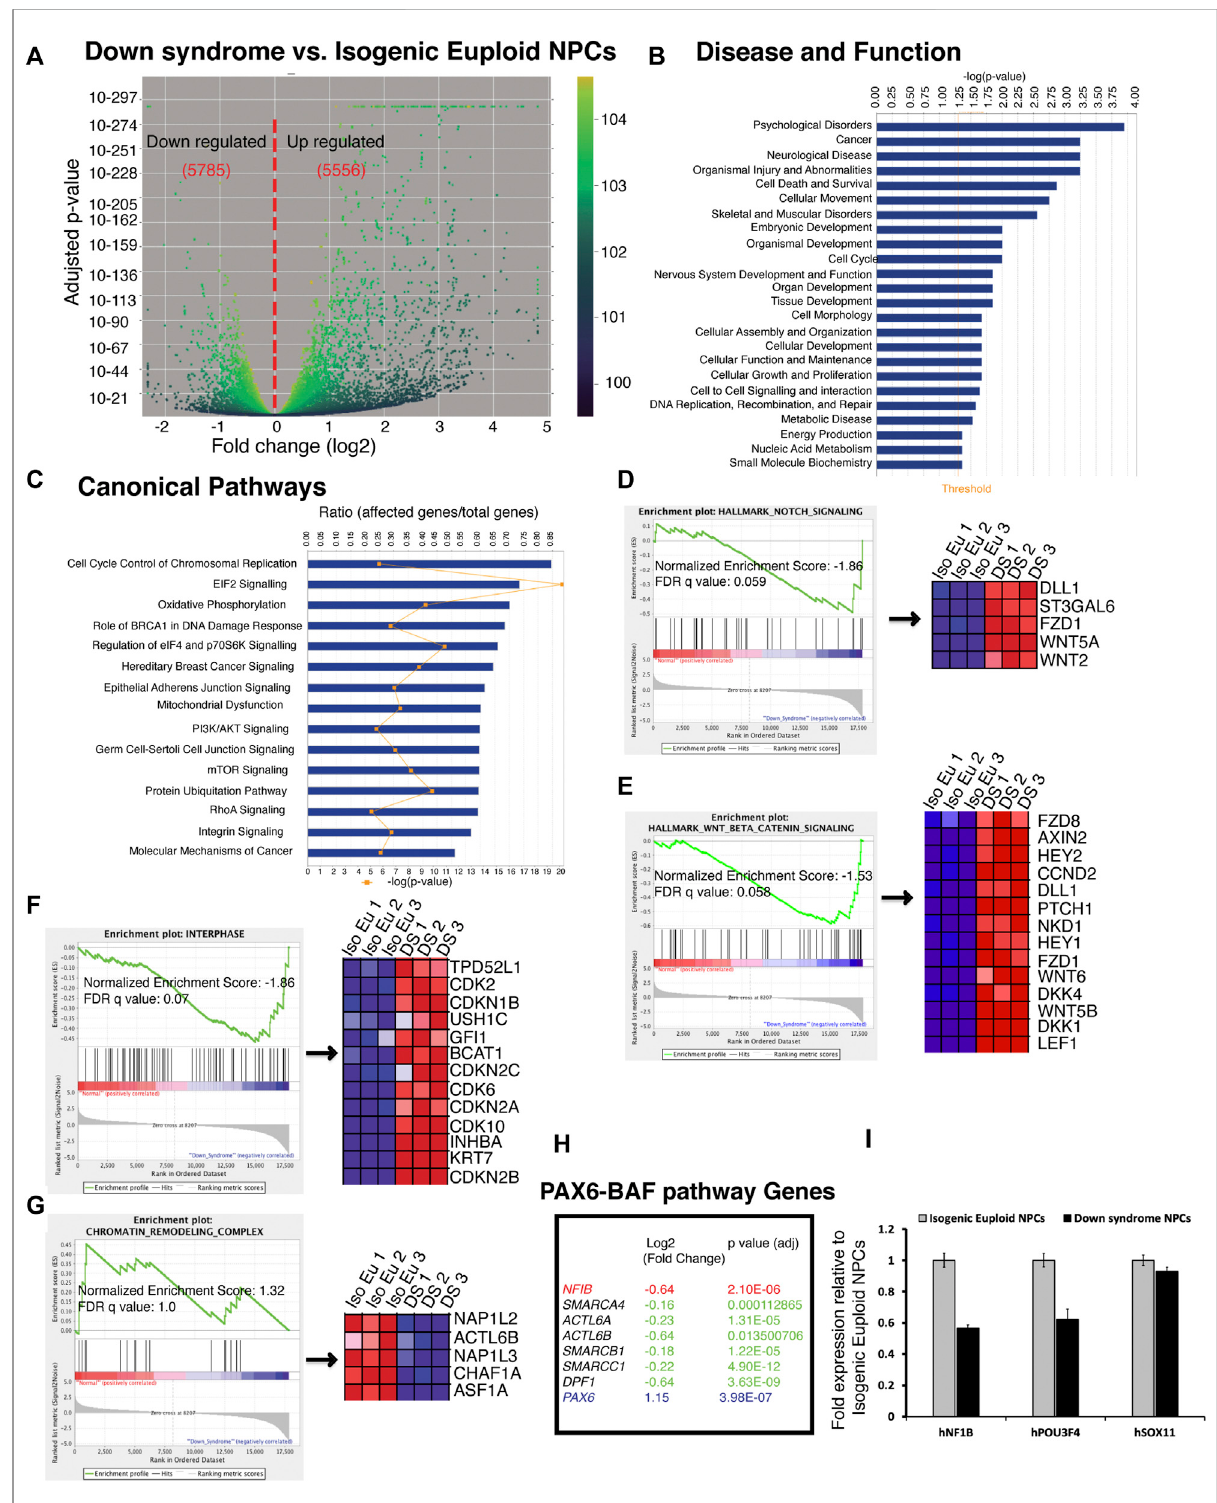
FIGURE 6 RNAseq analysis of global gene expression of Down syndrome and isogenic euploid DIV 24 progenitor cells. (A) Volcano plot shows downregulated and upregulated genes in Down syndrome cells compared to isogenic euploid cells. The number of genes is shown in red. (B) Top disease and functions term found through Ingenuity Pathway Analysis (IPA) with differentially expressed gene set in DIV 24 DS cells. The bar chart ’ s threshold line (orange) represents a p -value of 1.3. (C) Signi fi cant canonical pathways are involved in the well-characterized cell signaling and